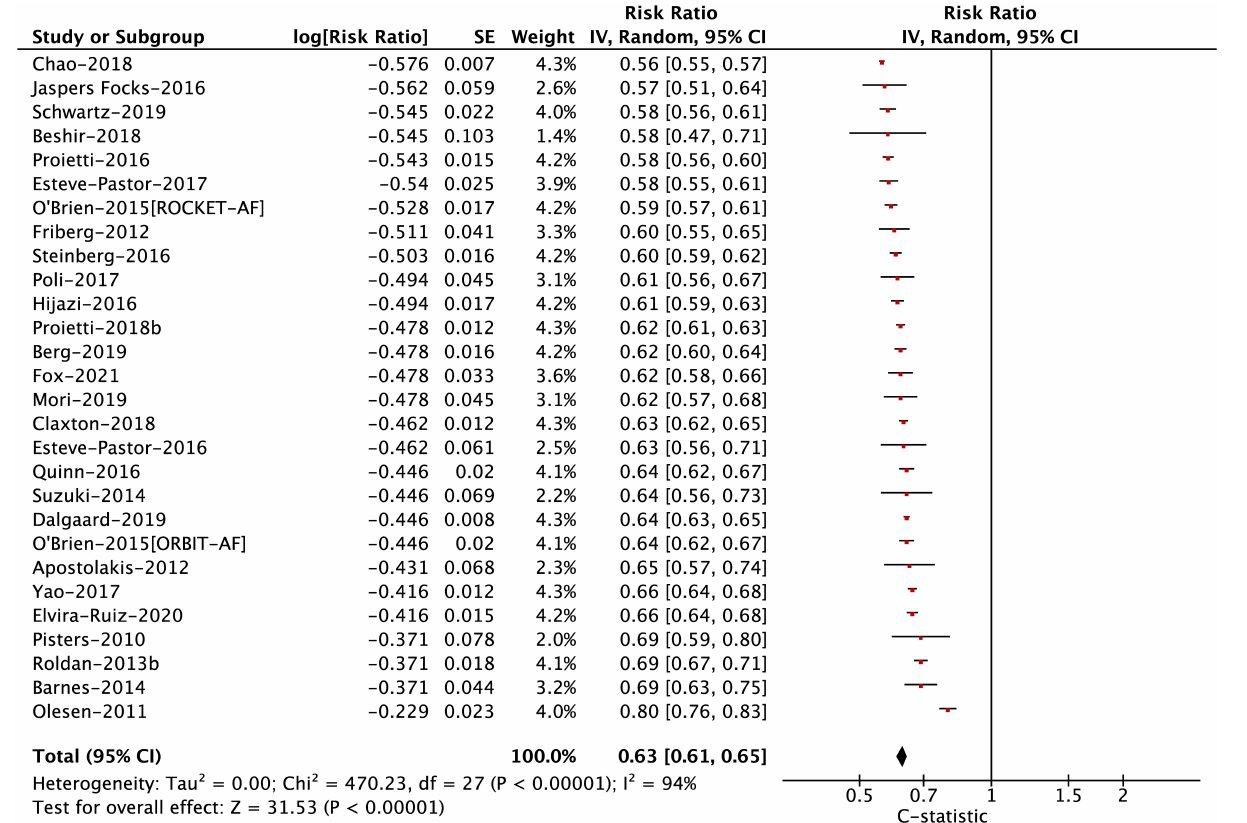
score (13, 30), but showed a similar or lower calibration compared with the ORBIT score (14,